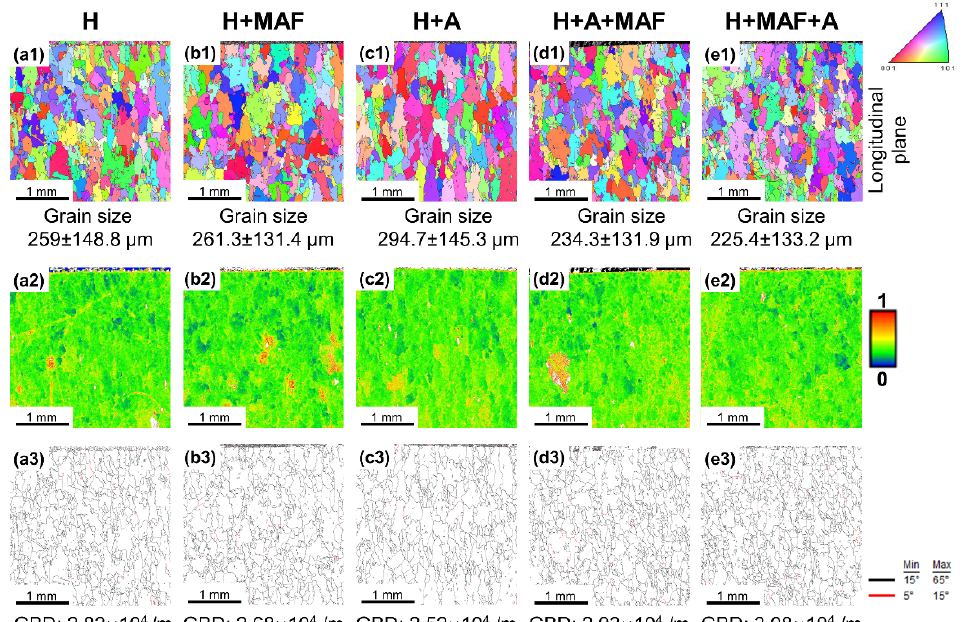
Figure 4. Microstructures analysis using EBSD maps of inverse pole figure (IPF), kernel average misorientation (KAM), and grain boundary density (GBD): ( a1 ) IPF, ( a2 ) KAM, and ( a3 ) GBD of the homogenized sample (H); ( b1 ) IPF, ( b2 ) KAM, and ( b3 ) GBD of the sample H + MAF (with the MAF process after homogenization); ( c1 ) IPF, ( c2 ) KAM, and ( c3 ) GBD of the fully heat-treated sample (H + A); ( d1 ) IPF, ( d2 ) KAM, and ( d3 ) GBD of sample H + A + MAF (with the MAF process after full heat treatment); and ( e1 ) IPF, ( e2 ) KAM, and ( e3 ) GBD of sample H + MAF + A (with the MAF process between the homogenization and aging processes). The grain boundary angle scale is given on the right-hand side of figure ( e3 ).